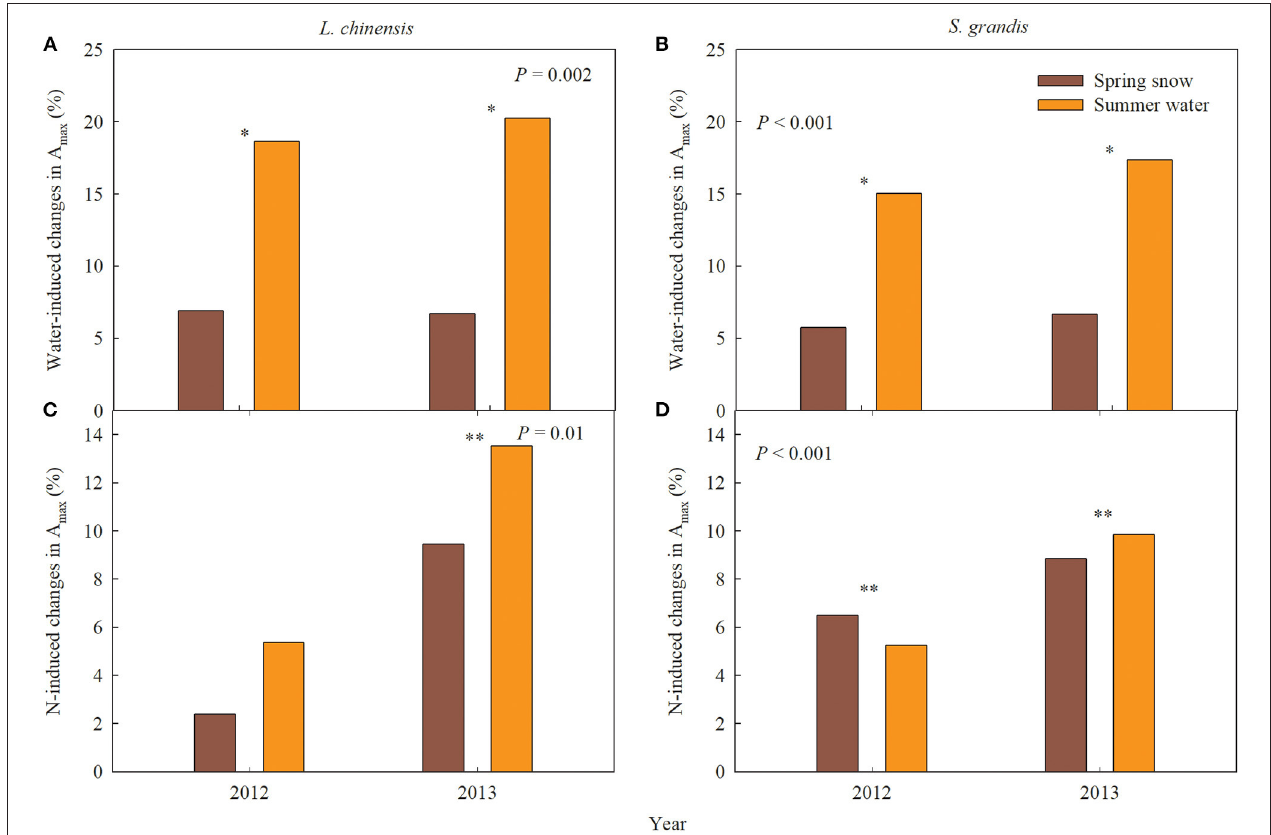
FIGURE 4 | Water- and nitrogen (N)-induced changes in leaf carbon exchange of Leymus chinensis and Stipa grandis in 2012 and 2013, respectively. (A,B) Spring snow- and summer water-induced changes in the maximum photosynthetic rate (A max ); (C,D) N-induced changes in the maximum photosynthetic rate (A max ). P -values in the figures represent the difference between spring snow or summer water effects across 2 years. ** and * on each group represent significant differences in t-test, at P < 0.01 and P < 0.05 levels, respectively.